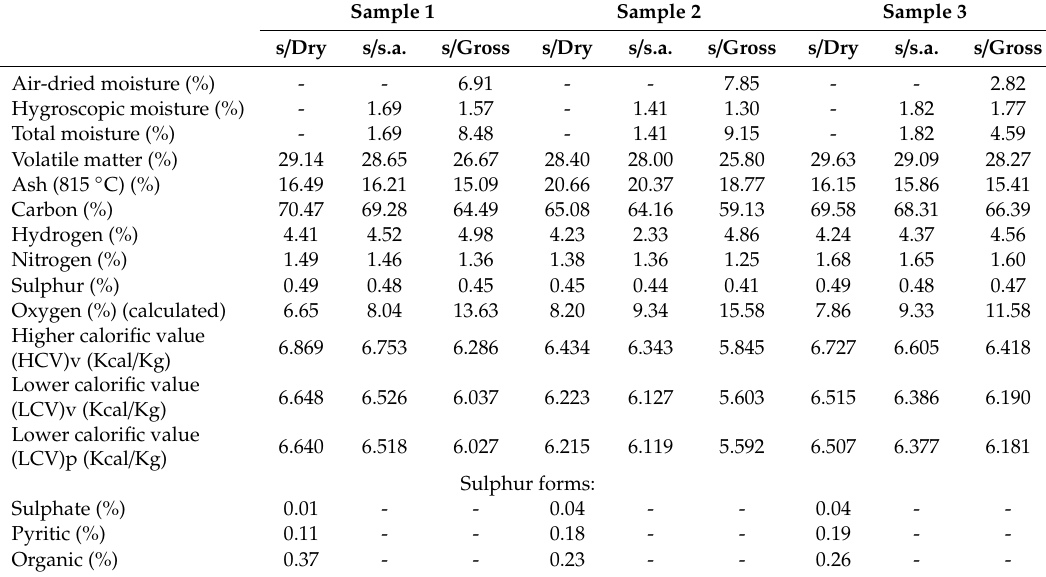
Table 1. Characteristics of the coal samples used in the